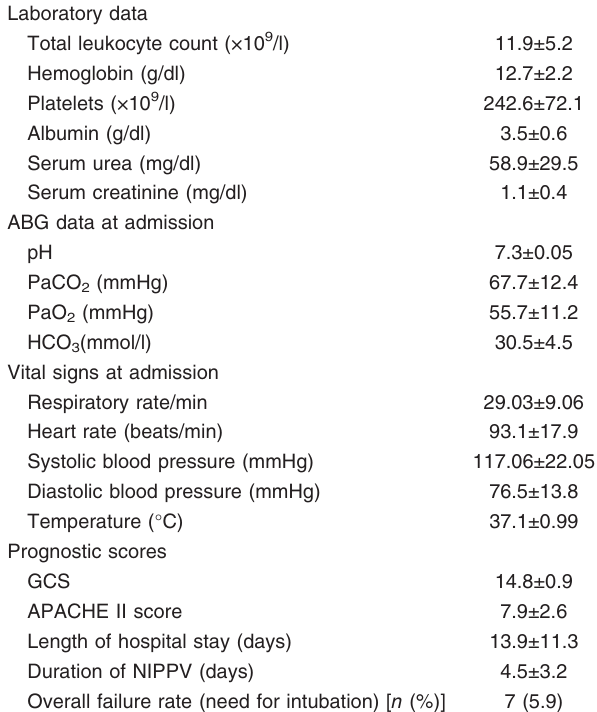
Table 2 Patient